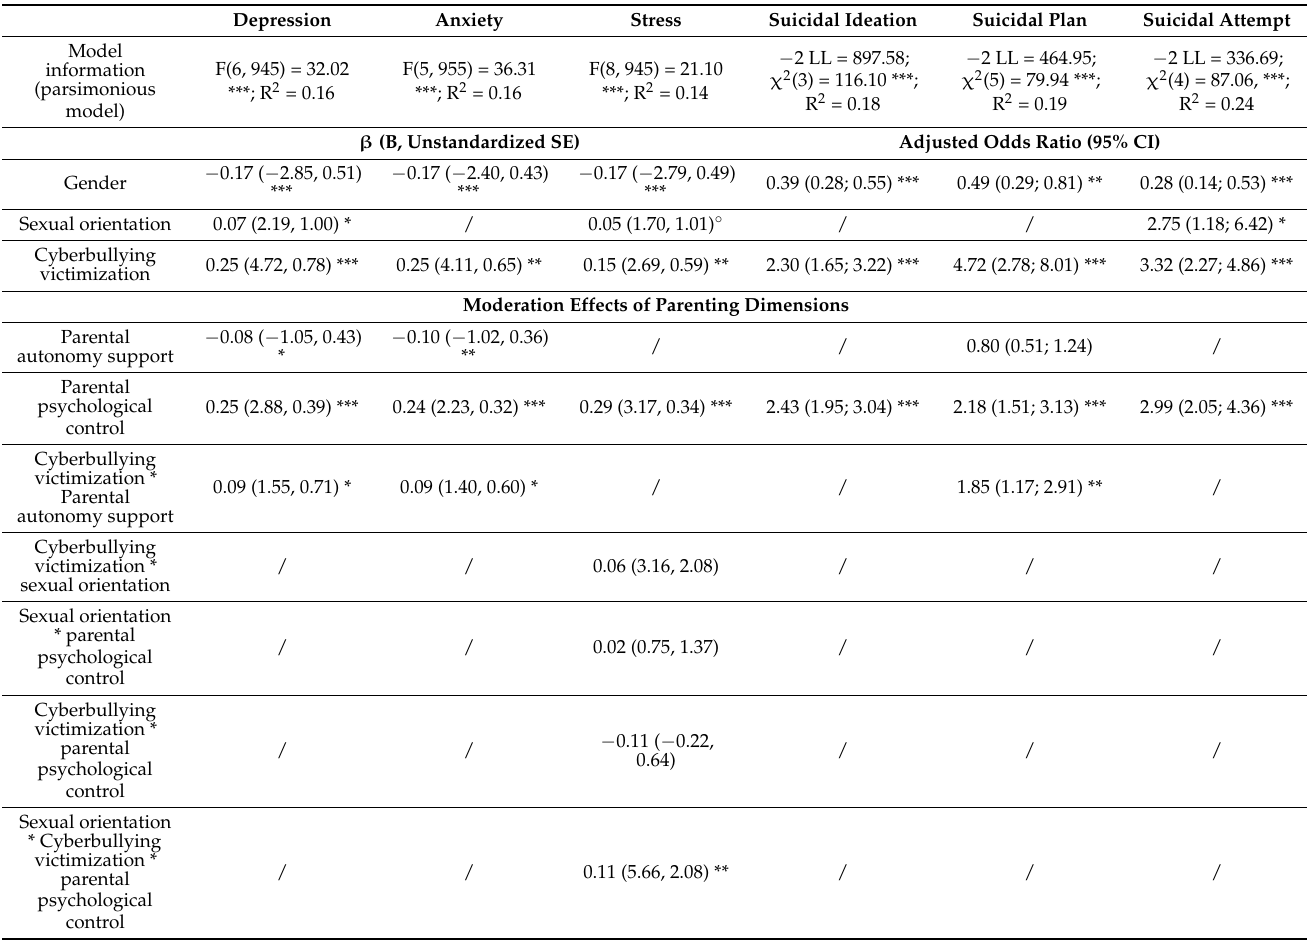
Table 4. Regression analyses for negative mental health outcomes and suicidal risk by cyberbullying victimization and sexual orientation. Underline: It was used to more clearly indicate what the difference is between the two tables where one shows traditional bullying and the other